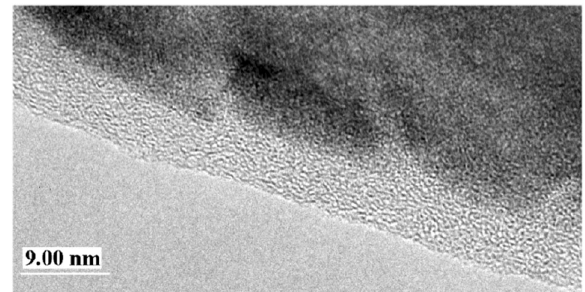
Fig. 6 TEM cross section of (Ca(U 0.5 Ce 0.25 Hf 0.25 )Ti 2 O 7 ) exposed for 835 days at RT in pH 4 potassium acid phthalate buffer with 0.005